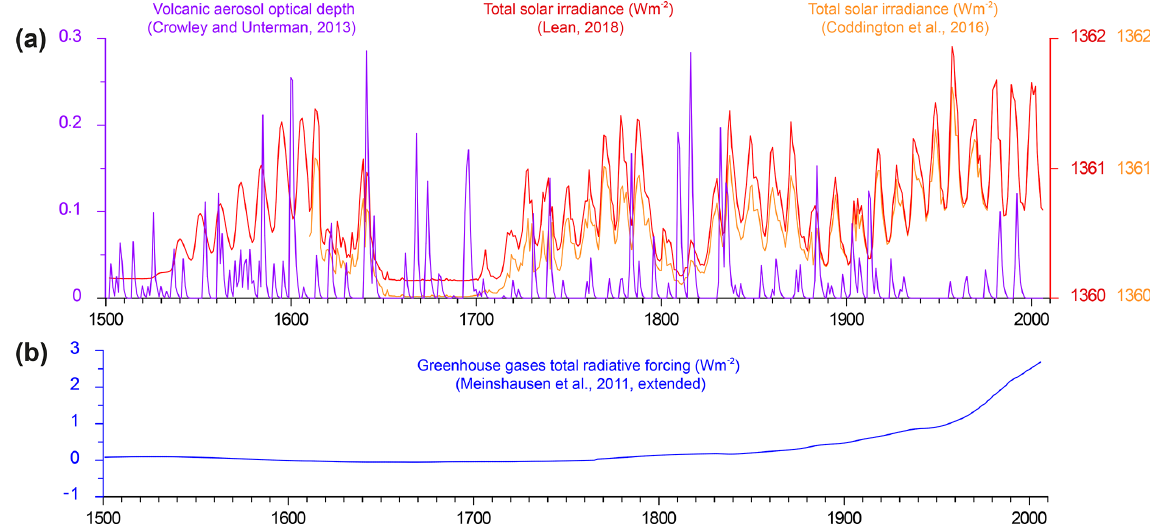
Figure 2. Annual series of external forcing descriptors: (a) volcanic aerosol optical depth and total solar irradiance; (b) greenhouse gases radiative